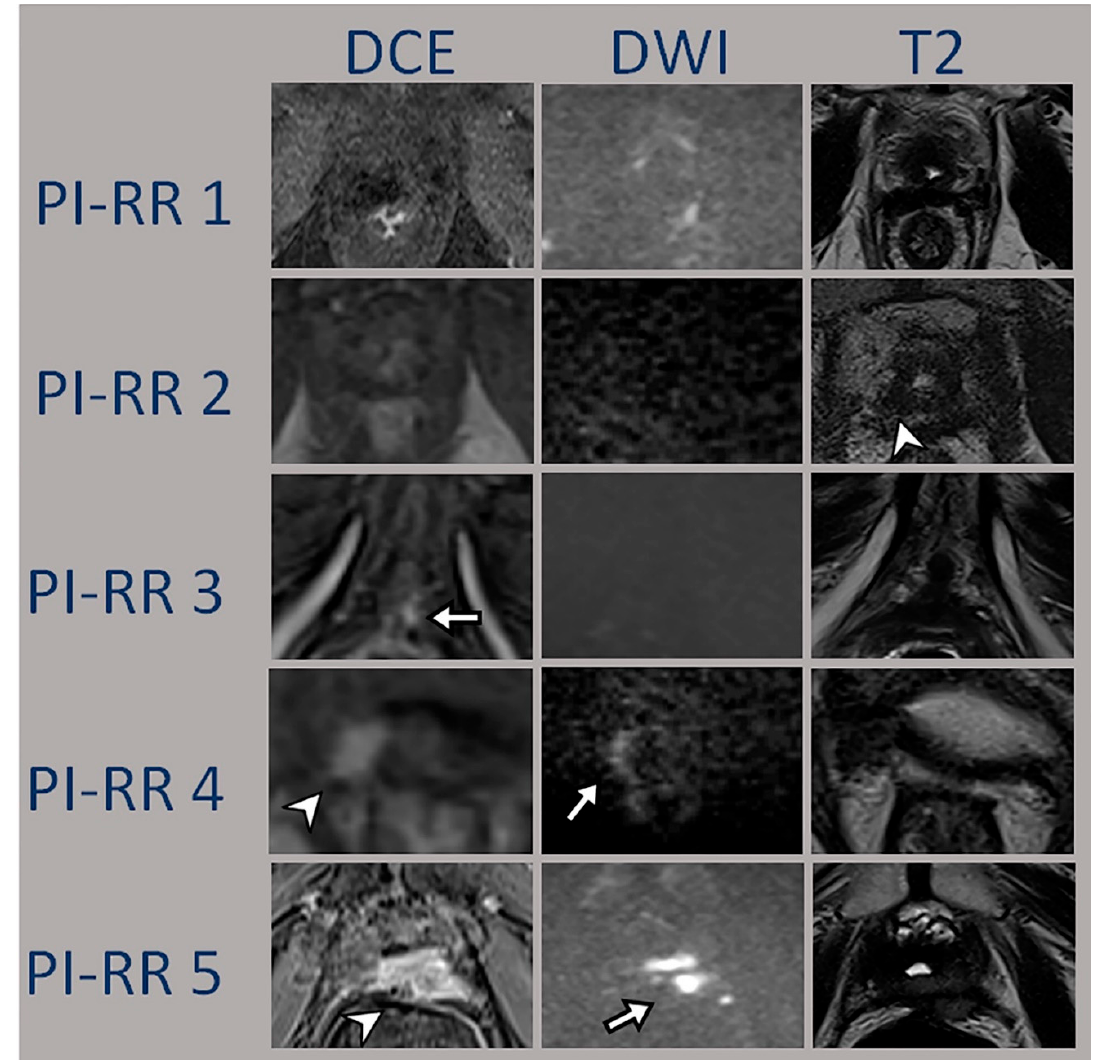
Figure 1. Examples of mp MRI in patients previously treated with radical prostatectomy. Axial MRI images of patients previously treated with radical prostatectomy.